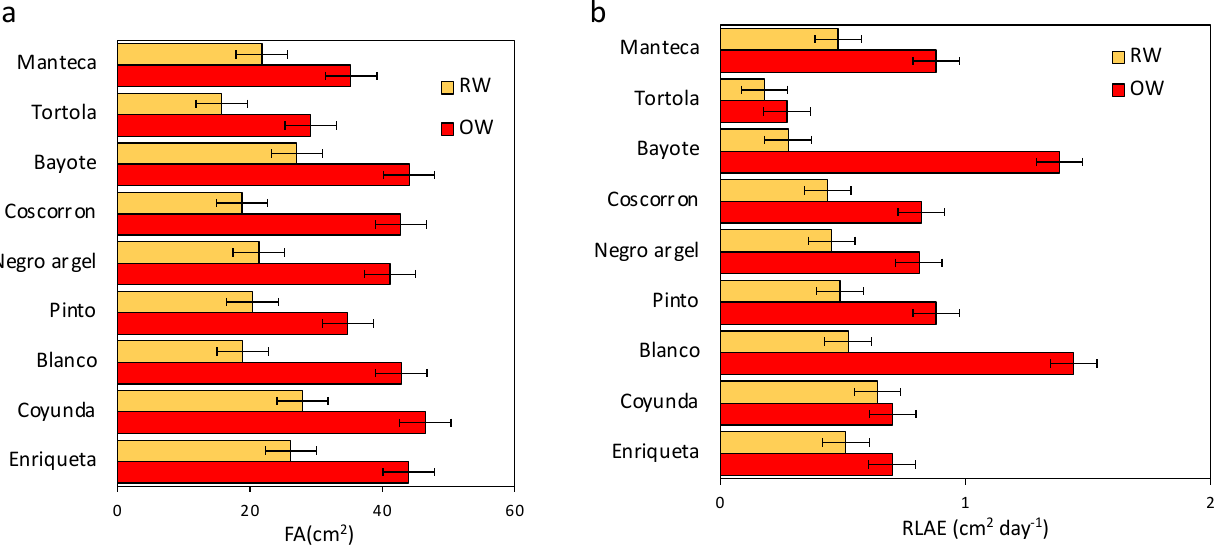
Figure 3. Effect of water stress on the rate of leaf growth for nine common bean Chilean landraces. ( a ) The relative rate of leaf area expansion (RLAE) was evaluated under OW (red bar) and RW (orange bar) treatments. ( b ) Leaf area expansion reduction corresponds to a reduction rate of RLAE in RW with respect to OW. Bars in ( a ) represent the mean of three biological replicates, while the error bars indicate the least significant differences (LSD) value of the interaction water conditions by varieties at p <